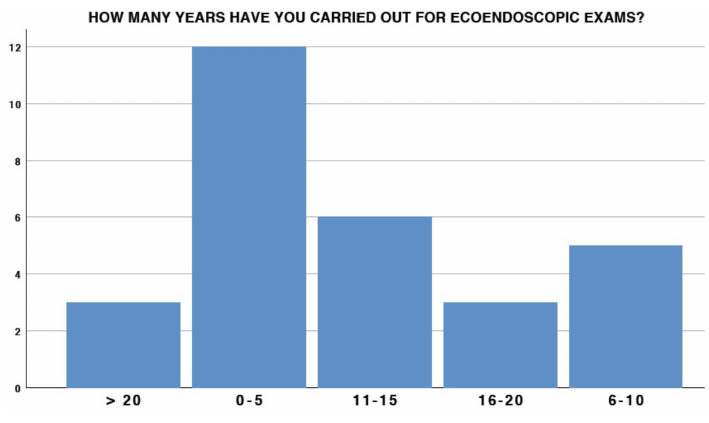
Figure 1. EUS experience.